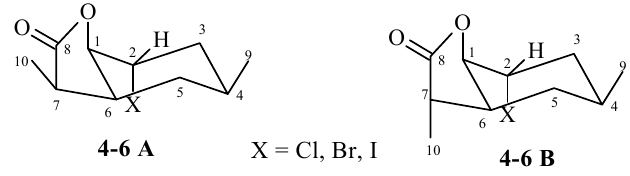
Figure 3. The structures of halolactones 4 – 6.